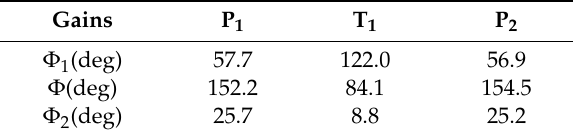
Table 1. The geometric parameters of grains P 1 , T 1 and P 2